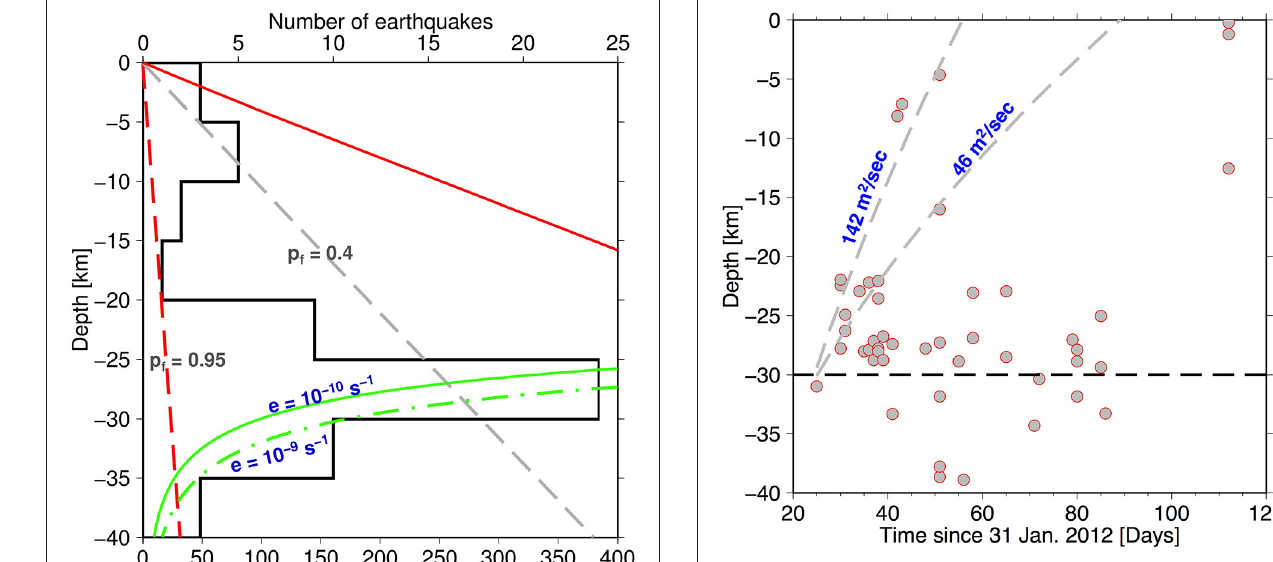
FIGURE 6 | Time-depth progression of earthquakes in the central MER (Lapins et al., 2020) for hydraulic diffusivity, D, of 142 and 46 m 2 /s. The broken black line at 30 km depth shows where most of the seismicity